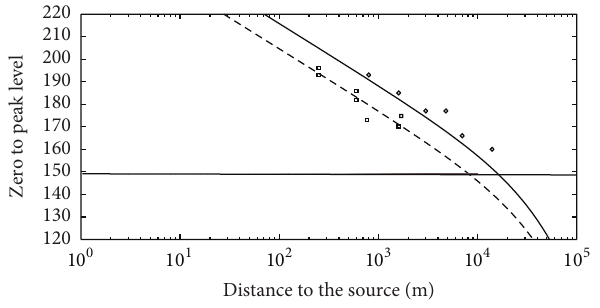
Figure 2: Application of the propagation model to jacket piling (dashedline)andmonopiling(plainline).Squaresandcirclesarethe measured 𝐿 𝑧−𝑝 , respectively, for jacket and monopile (Table 1) while the horizontal line at 149dB re 1 𝜇 Pa represents the level ( 𝐿 𝑧−𝑝 ) for major behavioural disturbance for harbour porpoise